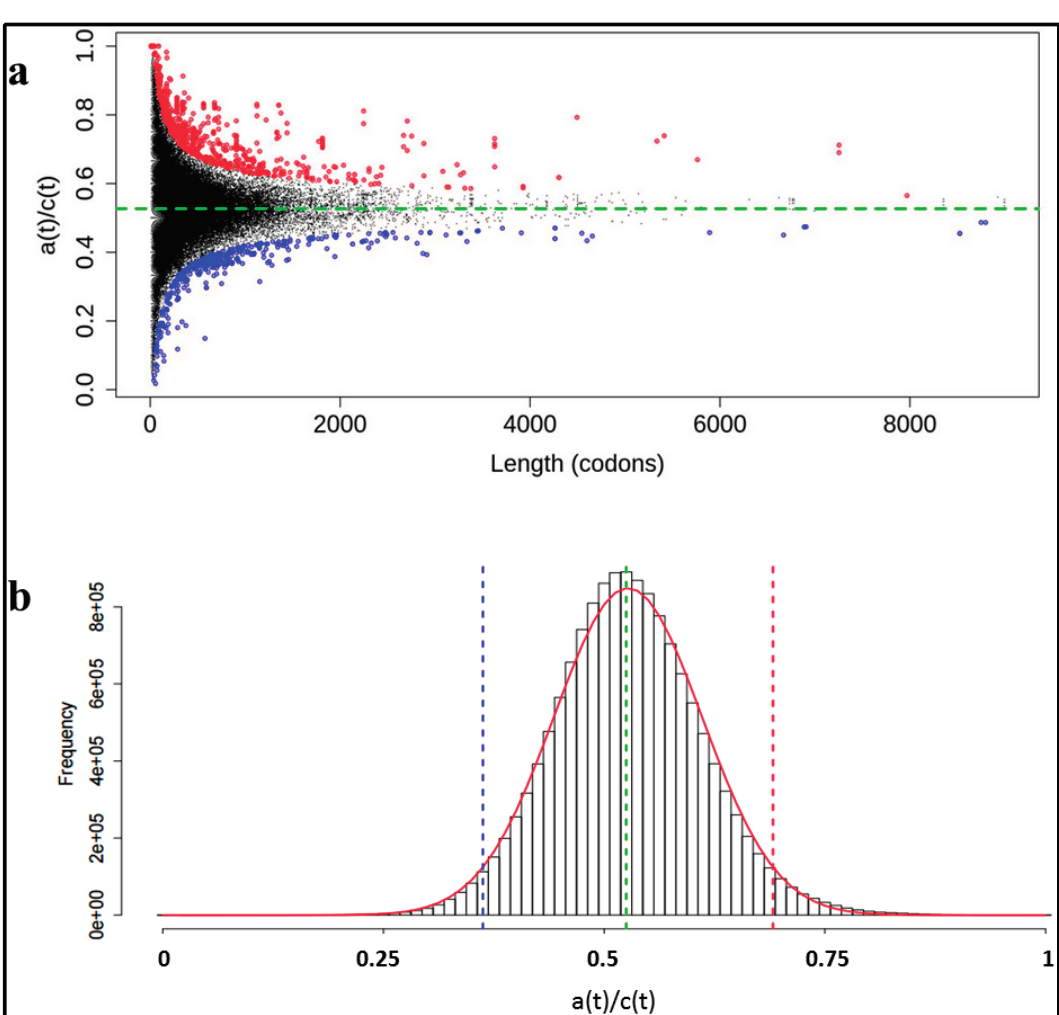
Figure 2. ( a ) Distribution of the human transcriptome using the Halves method to study the enrichment in A codons . The dashed green line shows the mean of A codons in the human transcriptome (0.527). Black dots correspond to all the regions obtained with this method (see Section 2.3). Red circles correspond to the enriched regions (2666). Blue circles correspond to the unenriched regions (412). Both regions are calculated supposing a binomial distribution with p -value <10 − 11 ; ( b ) Running Windows Method distribution. a ( t ) enrichment for all the windows. Red line is the normal distribution following this histogram. Blue and red dashed lines show where the tails of the distribution represents a 5%. Green dashed line shows the